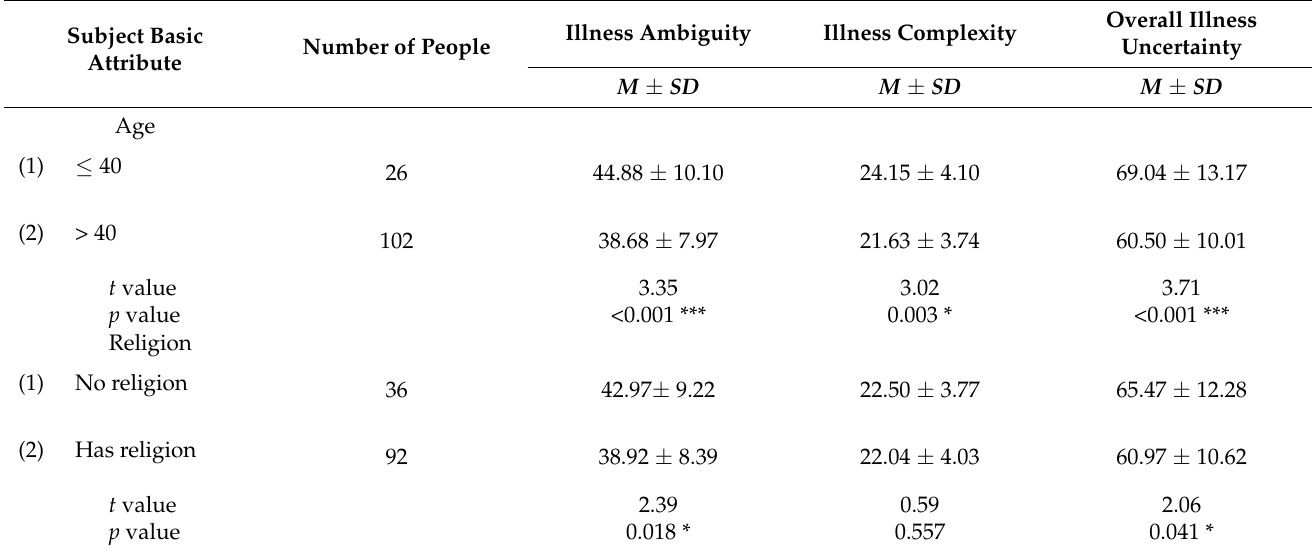
Table 2. Differences in illness uncertainty between subject basic attributes (n = 128).